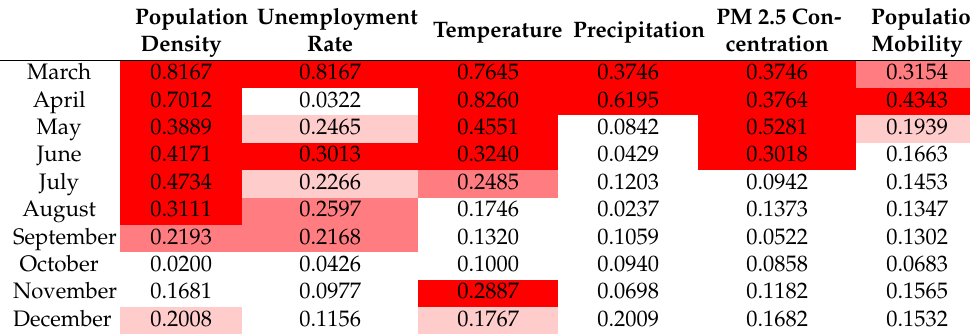
Table 4. Explanation of the power of influencing